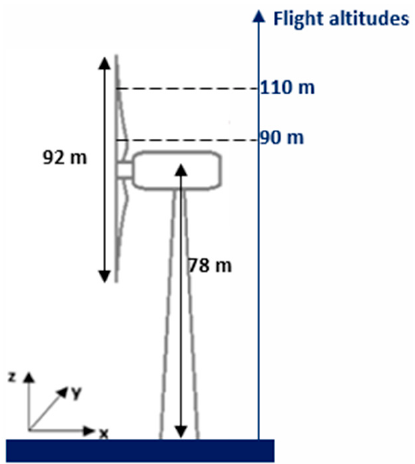
Figure 2. Schematic showing the wind turbine dimensions and the flight altitudes.